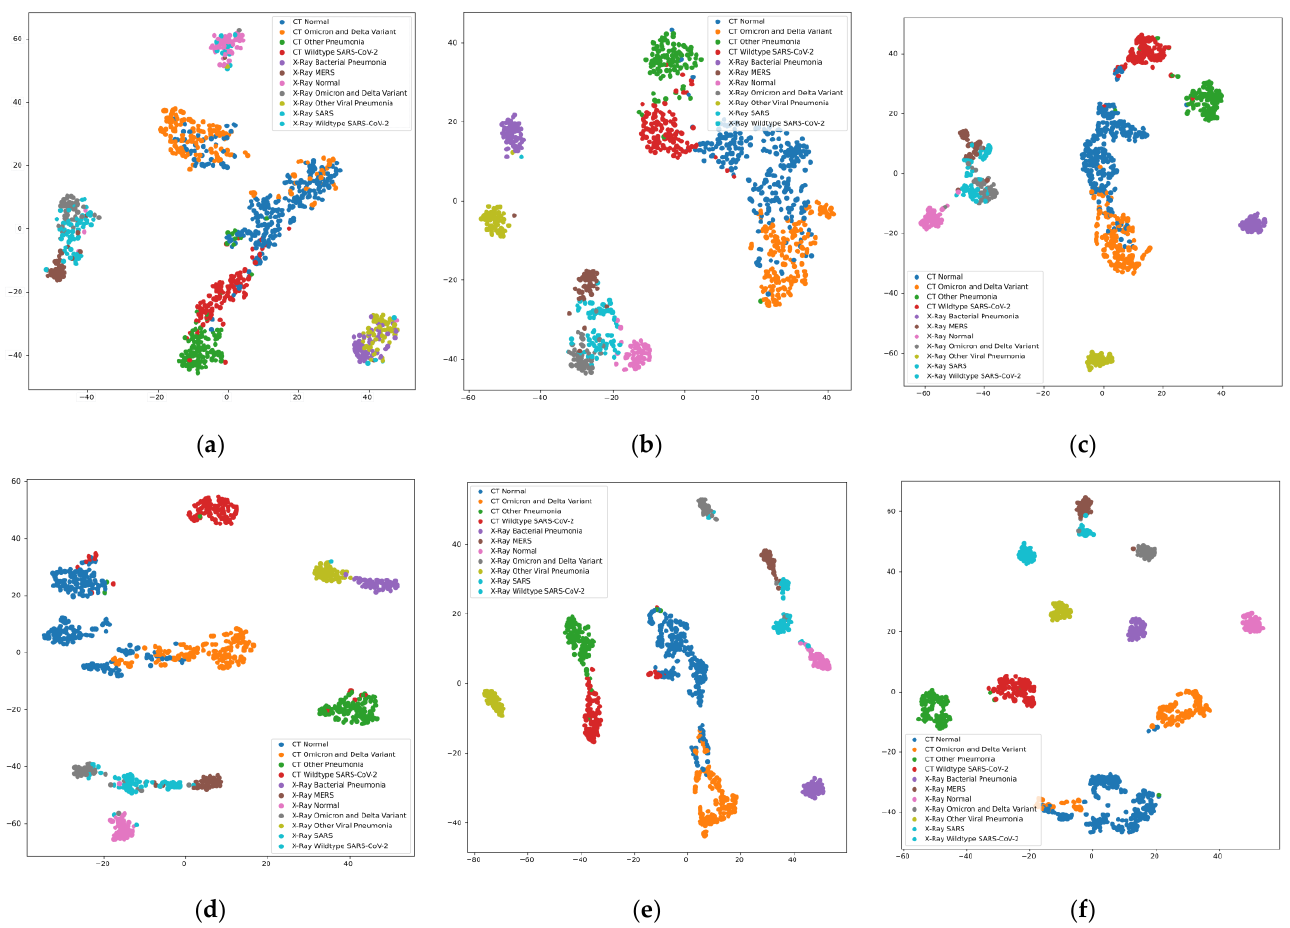
Figure 5. Results of t-SNE visualization for high-dimensional data clustering: ( a ) MLP-Mixer B/16; ( b ) Efficientnet-b4; ( c ) ResNet-50; ( d ) ViT-B/16; ( e ) BeiT-v2; ( f ) CoroTrans (ours).